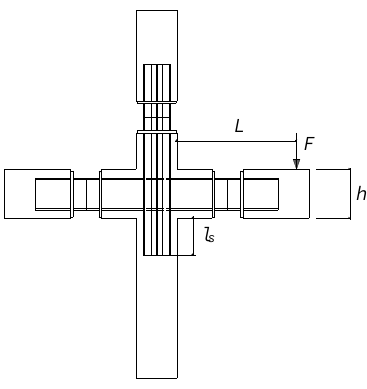
Figure 6. Diagrammatic sketch for each parameter. Solid element C3D8R was used for the concrete and steel plate, and truss element T3D2 was used for reinforcement. The reinforcement and steel plate were embedded in concrete. The schematic diagram of mesh dividing for the PPSRC beam–column joint is shown in Figure 7. The boundary conditions of the finite element model were set before the numerical analysis. The displacement in the X, Y, Z directions and the rotation angle in the X, Y directions were constrained at the bottom of the column, while the displacement in the X, Z directions and the rotation angle in the XZ, YZ planes were constrained at the top of the column. In addition, the vertical load was applied at the top of the column. Moreover, the displacement in Y direction was only released at the end of the beam.